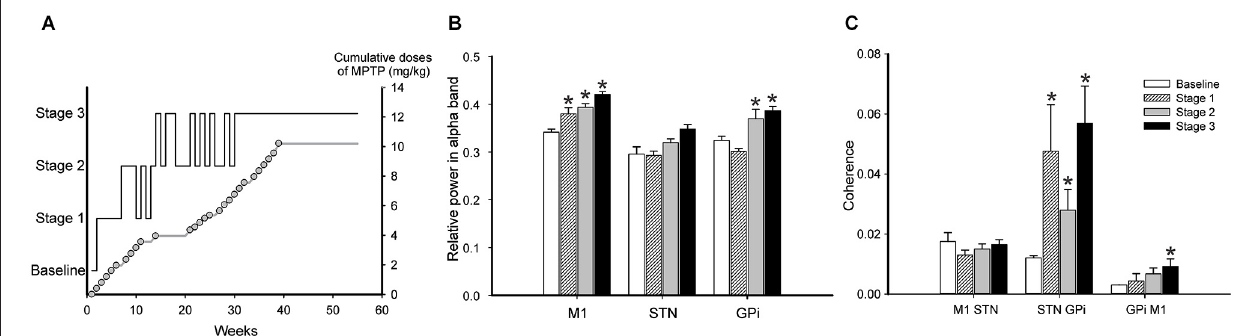
cumulative dose of MPTP is shown as a gray line with open circles, where each circle corresponds to a single MPTP injection. Stages 1–3 represent mild, moderate, and moderately-severe parkinsonism, as judged by a parkinsonian rating scale. (B) Relative spectral power (mean ± SEM) of M1, STN and GPi signals (EEG, LFPs) across the different stages. (C) Coherence between M1 and STN, STN and GPi, and M1 and GPi signals in the 7.8–15.5 Hz frequency range across different stages of parkinsonism during periods of wakefulness. * p < 0.05 vs. baseline (2-way ANOVA with post hoc Holm-Sidak test). Modified from Devergnas et al. (2014), with